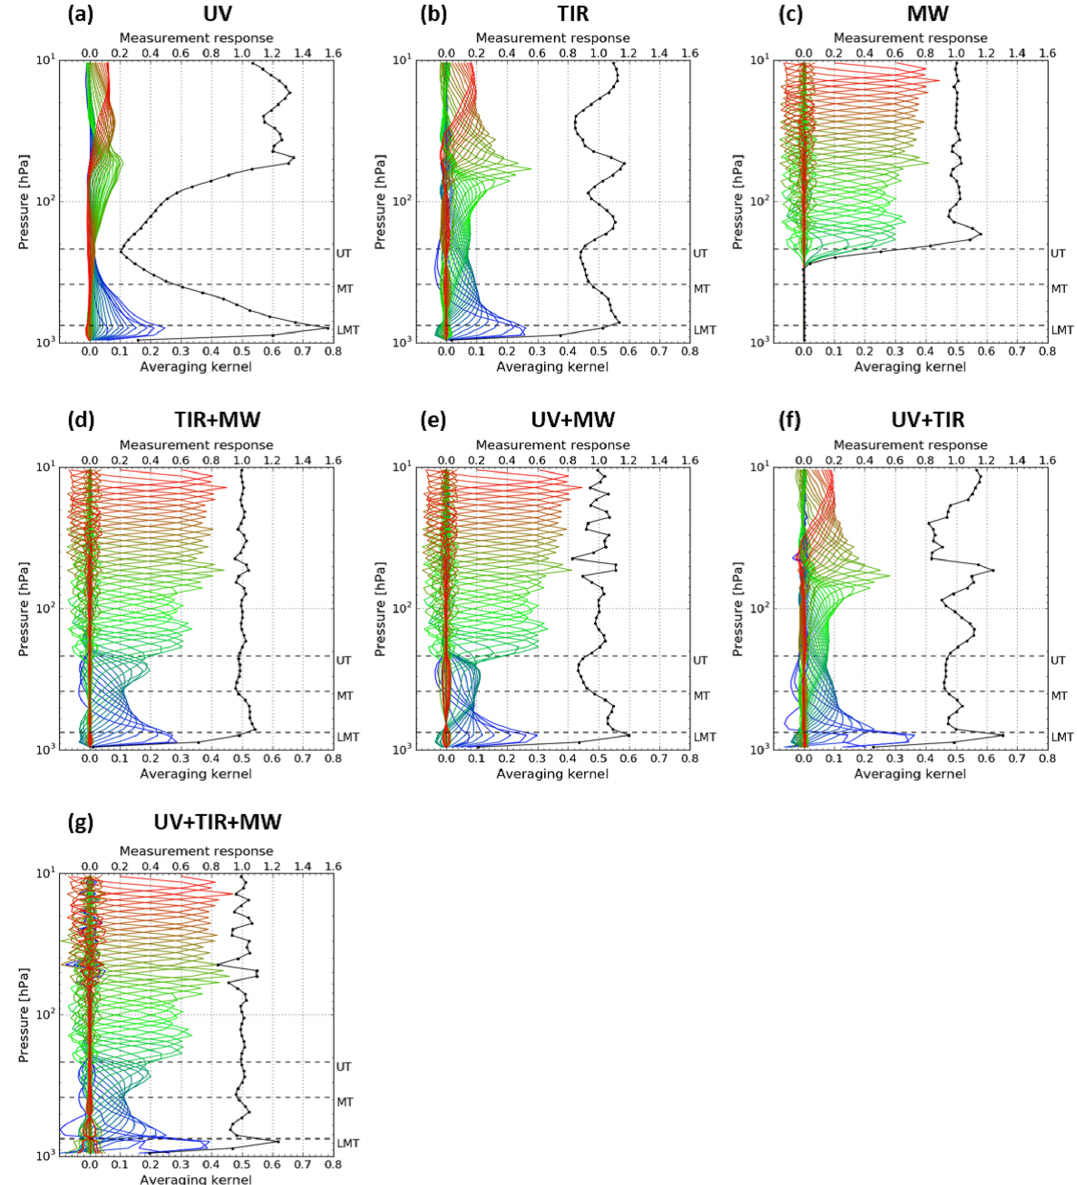
Figure 5. Averaging kernels for atmospheric profile no. 01 (more ozone enhancement in LMT, CEC in June 2009) for seven wavelength measurements: (a) UV, (b) TIR, (c) MW, (d) UV + TIR, (e) UV + MW, (f) TIR + MW, and (g) UV + TIR + MW. Measurement responses are shown by black dots and